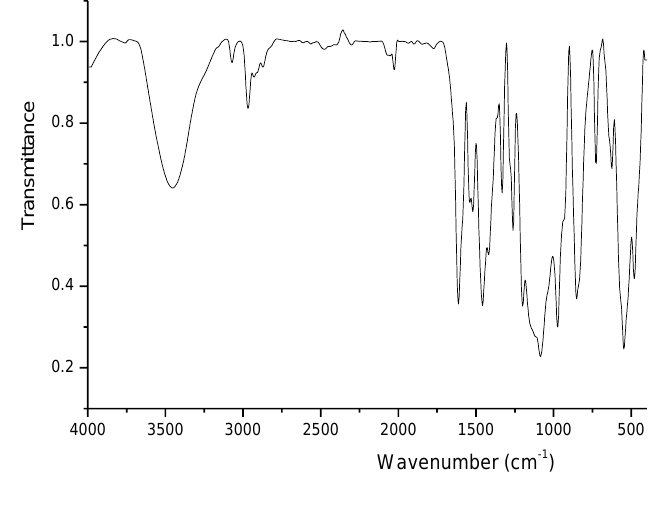
Fig. S2. IR spectrum of complex 1 .